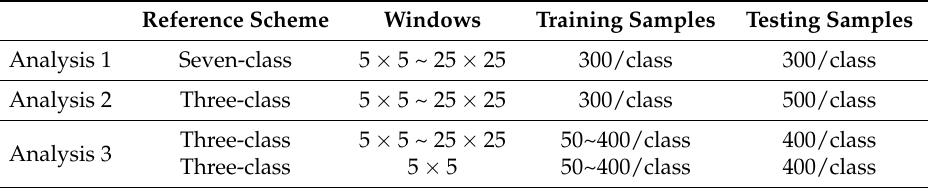
Table 3. Classification conditions of the analyses.